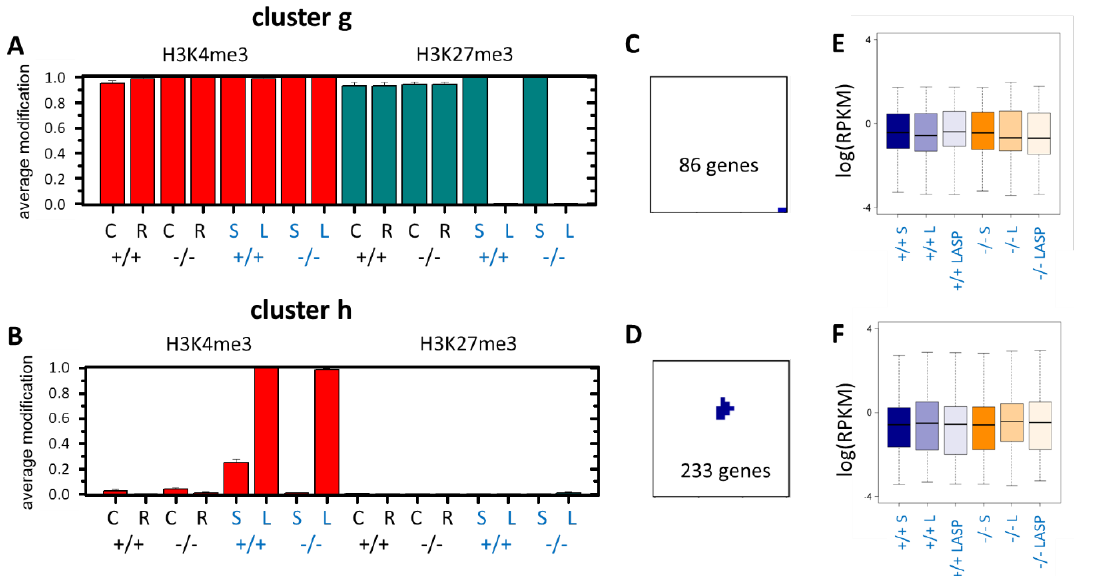
Figure 5. Epigenetic activation during the long-term organoid culture. ( A ) The loss of H3K27me3 at stable H3K4me3 in old organoids occurs in the 86 genes of cluster g . ( B ) The gain of H3K4me3 occurs in the 233 genes of cluster h . ( C , D ) Position of the clusters g and h in the SOM, respectively. ( E , F ) Box plots of the transcription of genes associated with clusters g and h , respectively. The average transcription of both clusters shows no differences in the short-term (S) culture, long-term culture (L) and long-term cultures supplemented with aspirin (LASP); Msh2 +/+ : +/+ and Msh2 −/− : −/− .